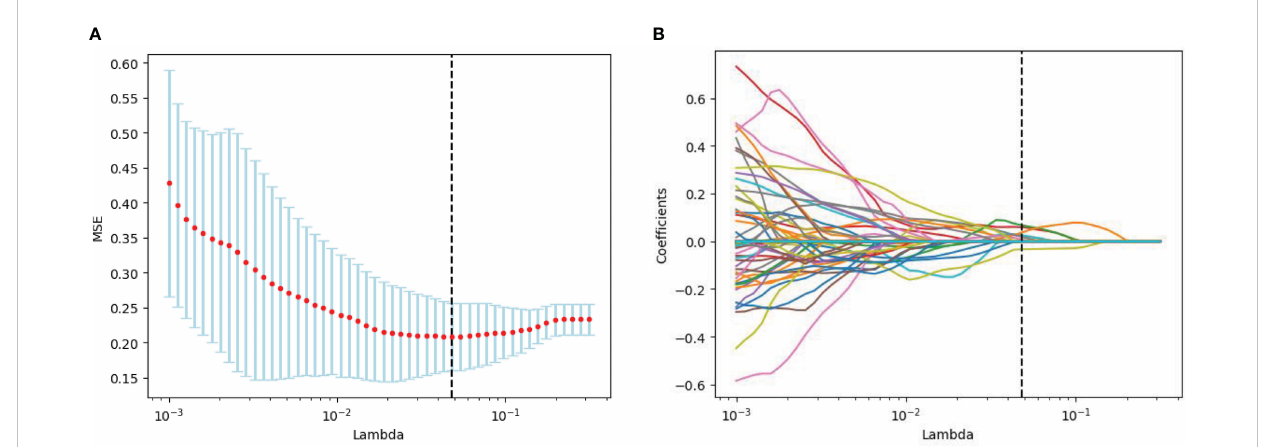
FIGURE 3 Radiomics feature screening by LASSO regression algorithm. (A) Plot of polynomial deviation versus l . The red dots represented the mean deviation value for each model with a given l , the vertical line was plotted at the best value by using the minimum criterion, where 7 features had non-zero coef fi cients. (B) Distribution of LASSO coef fi cients for radiological features. Each colored line represents the coef fi cient of each feature.